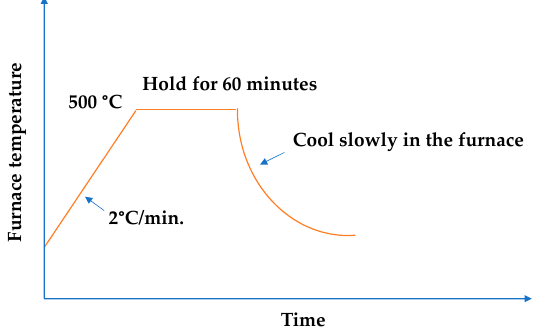
Figure 6. Heating process of the high-temperature